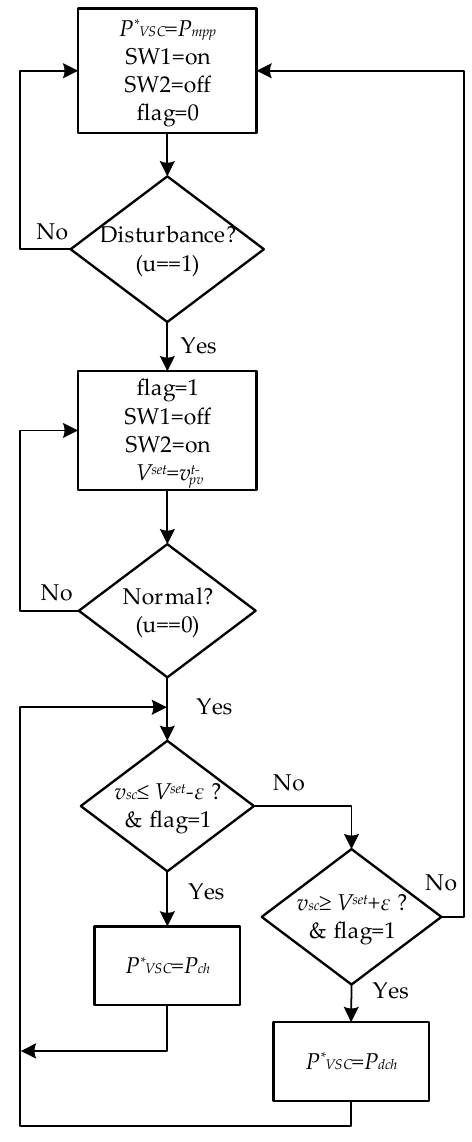
Figure 4. The control algorithm of the proposed PVSC system. During the day, while no disturbance is detected, the system works like a basic PV system to inject the maximum power generated by solar irradiance. Therefore, SW1 is closed (on), and SW2 is open (off), and the VSC reference power ( P ∗ ) is set to the PV maximum power ( P mpp ). Once a disturbance is detected by DDA such that u = 1, first the SW1 is opened and then the SW2 is immediately closed. In the moment of changeover from PV to SC, the last value of the PV voltage ( v t − ) is saved to be applied in the next changeover from SC back to PV. In addition, a flag is toggled to 1 to indicate that the changeover from PV to SC has occurred. The system will continue to handle the transient stability until the operating condition comes back to a normal situation and the DDA issues the signal u = 0. It should be noted that, during the transient period that the SC is switched on, the reference power is maintained at the previous value of P ∗ to have a smooth VSC